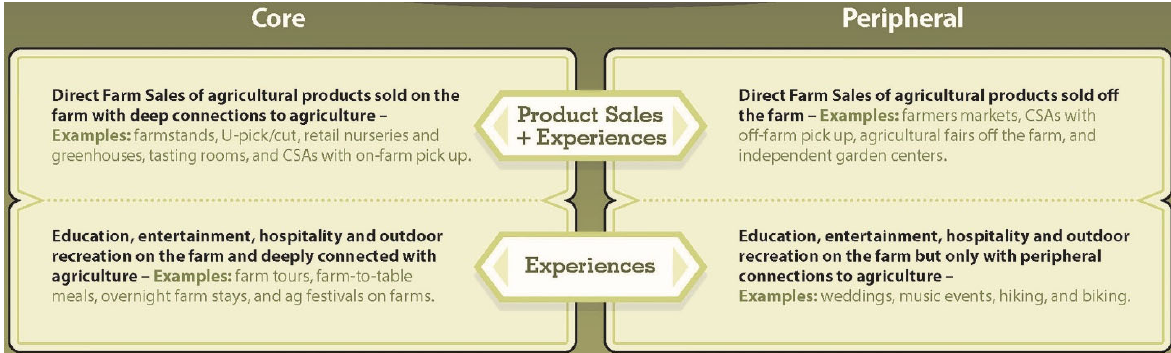
Figure 1. Core and Peripheral Tiers of Activities that May Be Considered